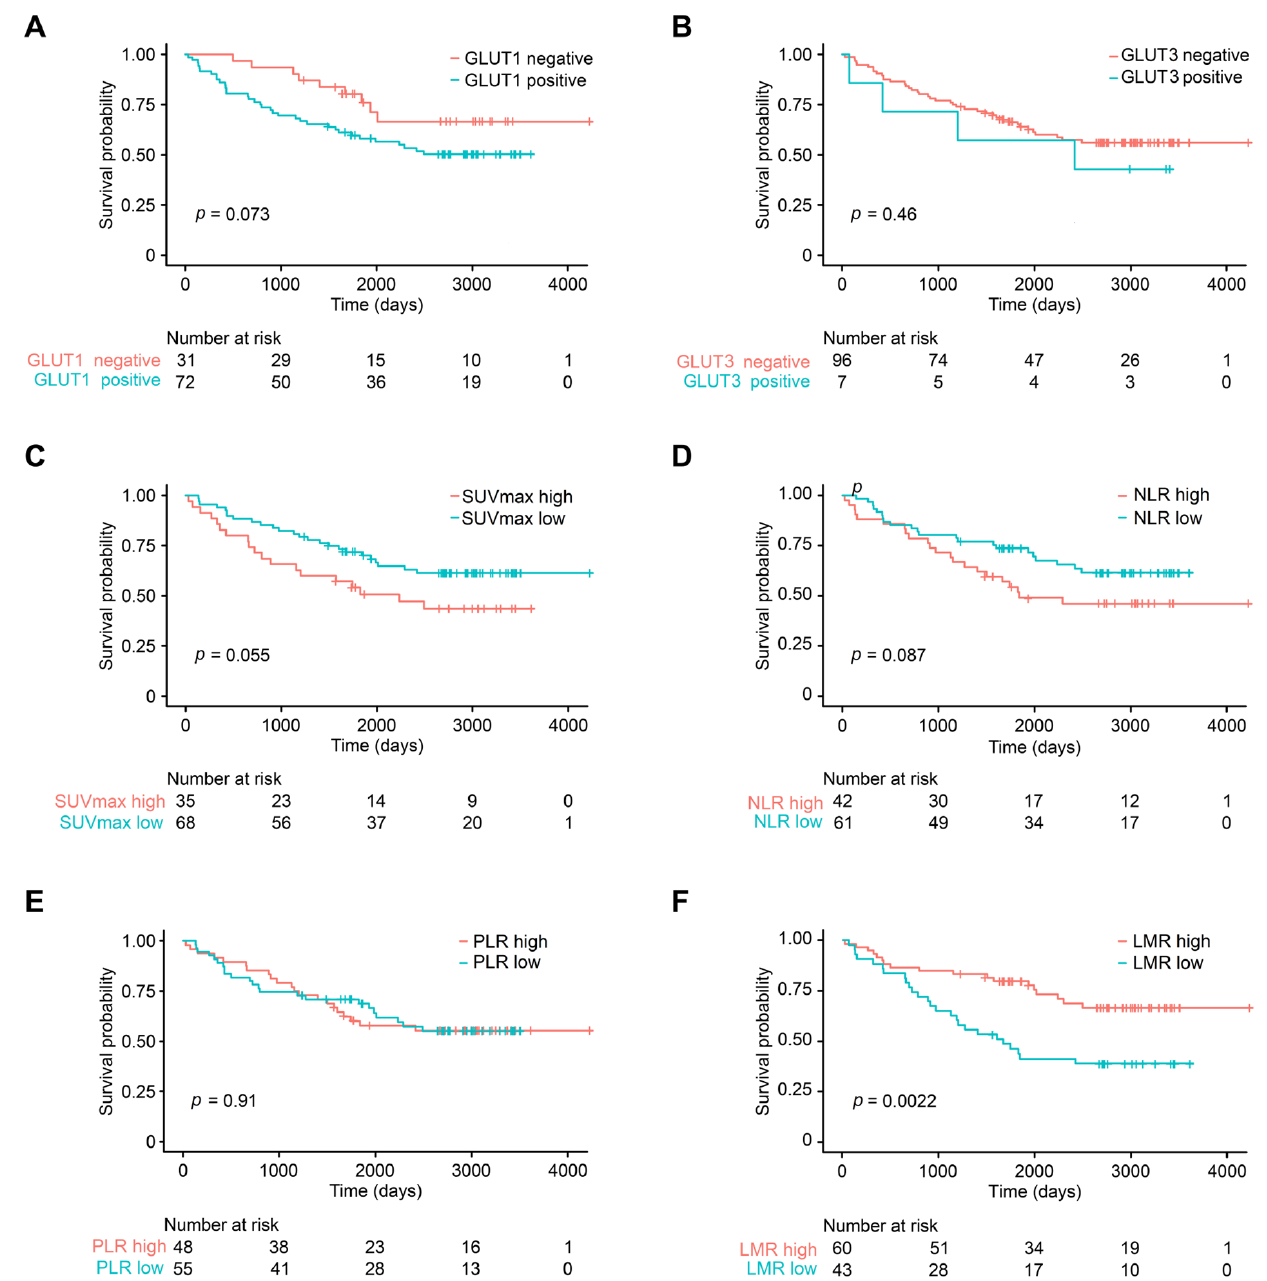
Figure 4. Kaplan–Meier survival curves of different parameters in patients with stage I/II non ‐ small cell carcinoma. ( A ) GLUT1 expression, ( B ) GLUT3 expression, ( C ) FDG ‐ PET SUV max , ( D ) neutrophil– lymphocyte ratio (NLR), ( E ) platelet–lymphocyte ratio (PLR), and ( F ) lymphocyte–monocyte ratio (LMR). FDG ‐ PET SUV max , fluoro ‐ D ‐ glucose ‐ positron emission tomography maximum uptake value.